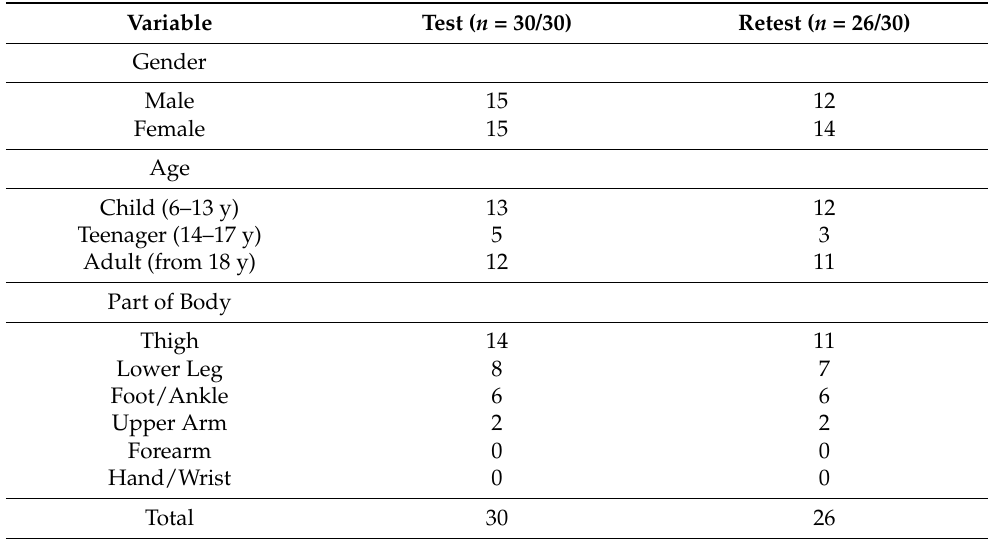
Table 1. Demographics of patients participating in the cognitive debriefing interviews and the test-retest.